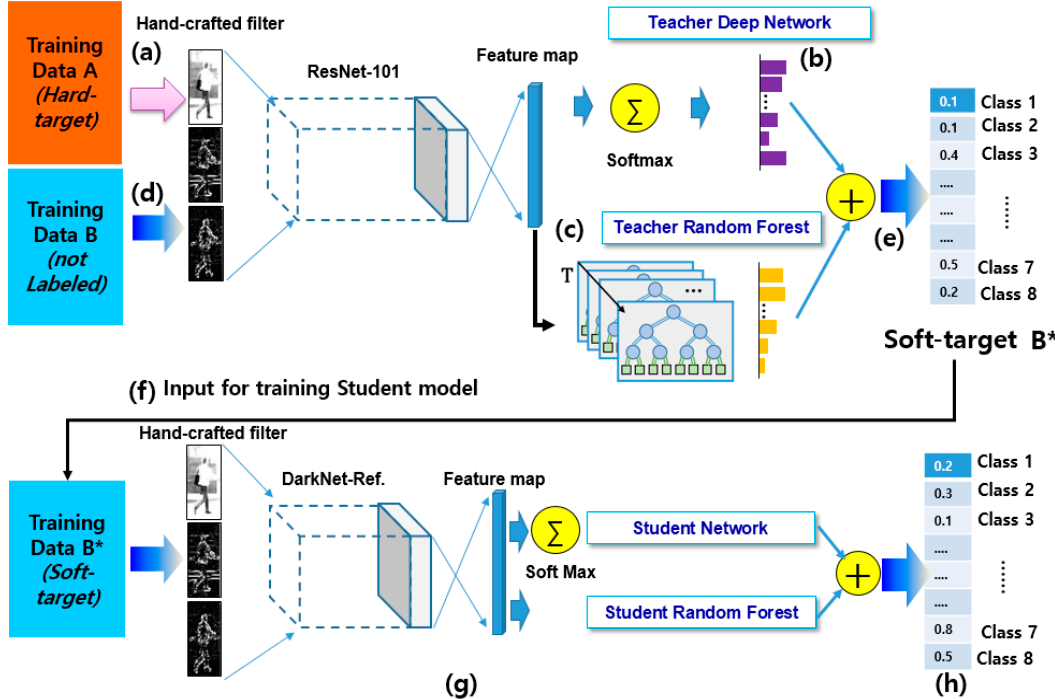
Figure 1. Teacher–student learning framework using hard- and soft-target data (in order of learning process): ( a ) dataset A labelled with a hard target input into the ( b ) teacher deep network and used for training teacher deep network, ( c ) teacher random forest (RF) is trained using feature maps of teacher deep network, ( d ) after finishing training of two-teacher model, unlabelled training dataset B input into the trained two-teacher model, ( e ) the soft output of the two teachers combined into one soft target vector and ( f ) a soft target dataset B ∗ of the teacher network are used for training the target student network, ( g ) training of the student model composed of student network and student RF, and ( h ) the final class probability is generated by combining output probability of two-student